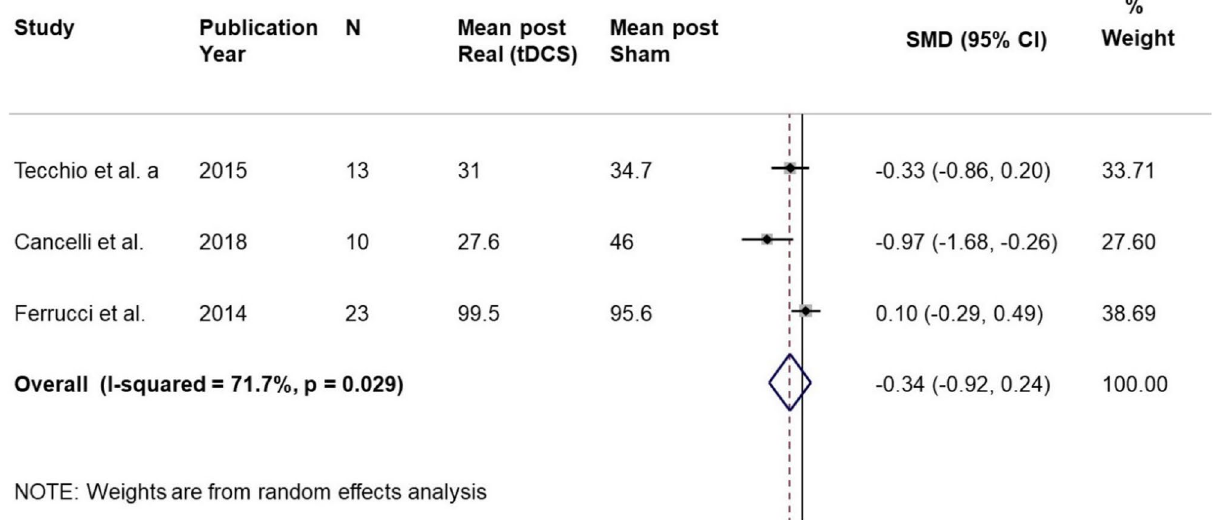
Figure 9. MS Fatigue. Real Vs Sham. Forest plot of meta-analysis results considering all studies. The diamond represents the pooled standardized mean difference (SMD, dashed red vertical line) and its 95% confidence interval; vertical solid dark line is the line of equivalence. The estimates for each study and their 95% confidence intervals are represented by a box with whiskers, the dimension of grey box is proportional to the precision of the study.